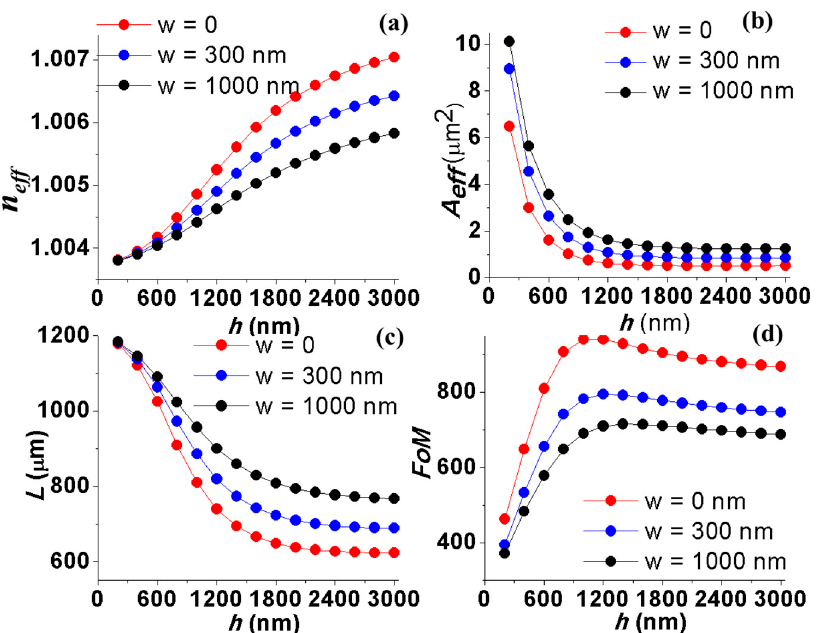
Figure 7. The propagation characteristics of the wedge-shaped SPP waveguide structure as a function of the height ( α = 54.74°, w = 0 nm, 300 nm, and 1000 nm): ( a ) effective mode index ( n eff ), ( b ) effective mode area ( A eff ), ( c ) propagation length ( L ) and ( d ) the figure of merit ( FoM ).